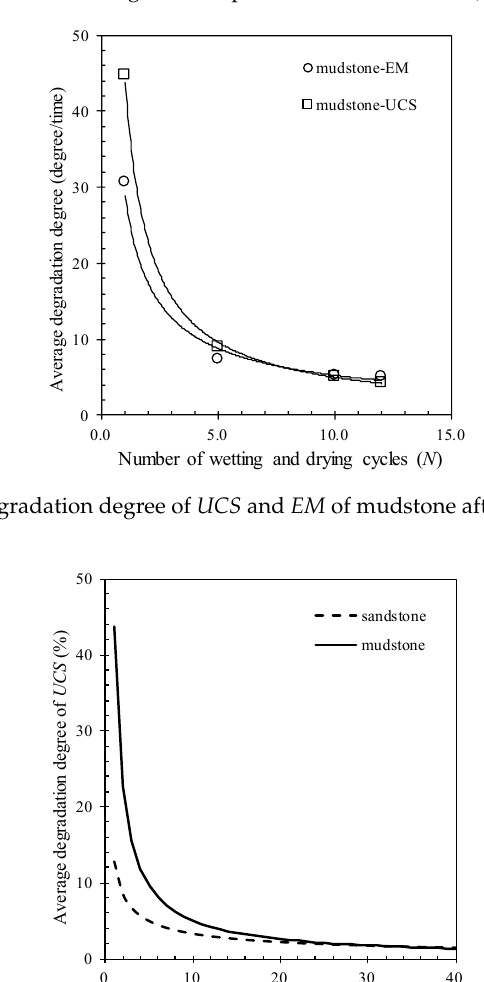
Figure 15. Fitted curves of average degradation degree of EM and wetting and drying cycles. 5. Discussion As mentioned above, the UCS and the EM of the selected specimens could be calculated by the value of N , but it was hard to know the specific value of N in the practical engineering. As is known, the water absorption and porosity represent the volume of void and cracks in rock specimens, therefore they can be used to define the damage induced by wetting and drying cycles. Also, because of the good linear relationship between the two parameters as mentioned above, the water absorption and the porosity could be considered equivalent. Figure 16 further shows the relationship between the UCS and the porosity of selected specimens, and Figure 17 shows the relationship between the EM and the porosity of selected specimens, both of them can be fitted by linear curves as follows: UCS = a n + b (19) EM = c n + d